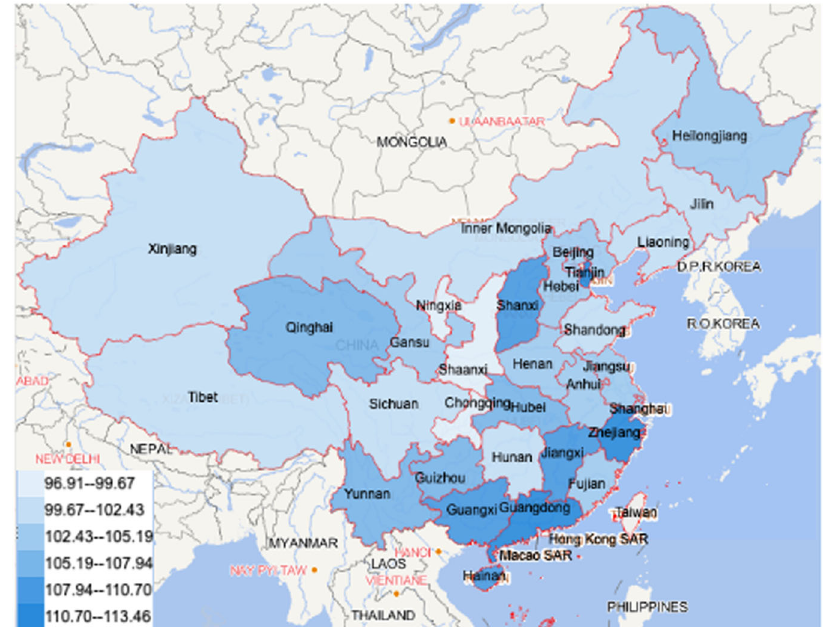
Fig. 2 Sex ratios of all Chinese provinces in 2021. Figure shows the regional distribution of gender imbalance in the 31 provinces studied in this article in the form of a map. Darker colors in the fi gure indicate a more serious gender imbalance.